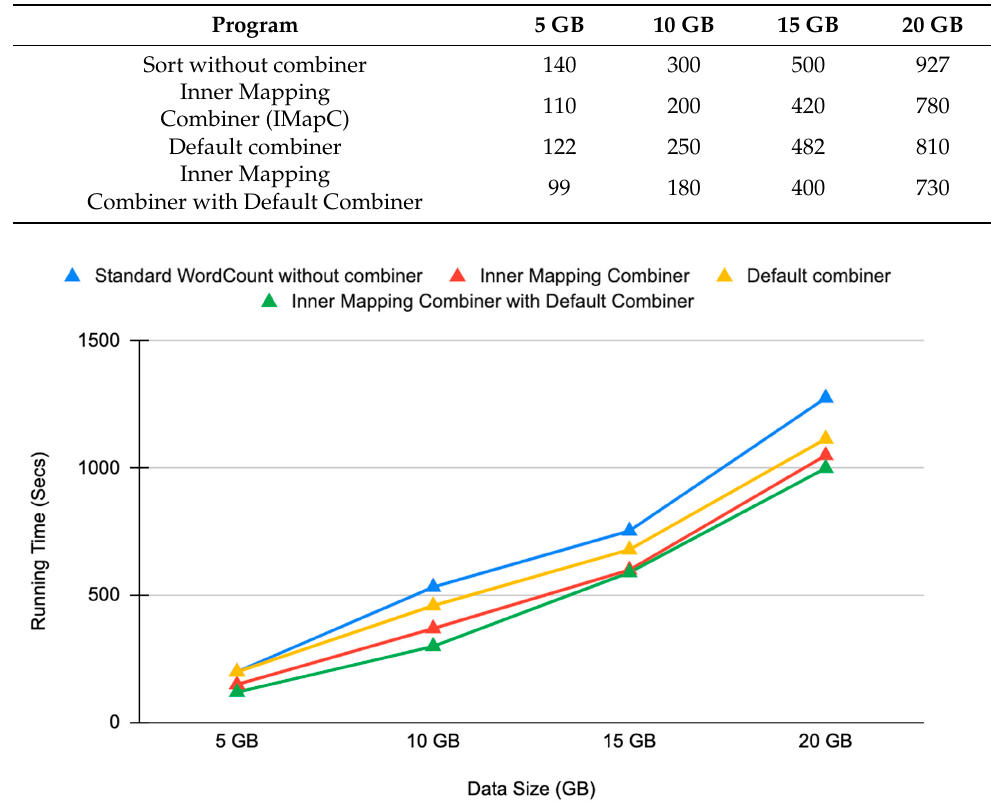
Figure 4. Execution time of WordCount program for the Inner Mapping Combiner (IMapC) over the Default Combiner and without the Combiner in Standard Hadoop.